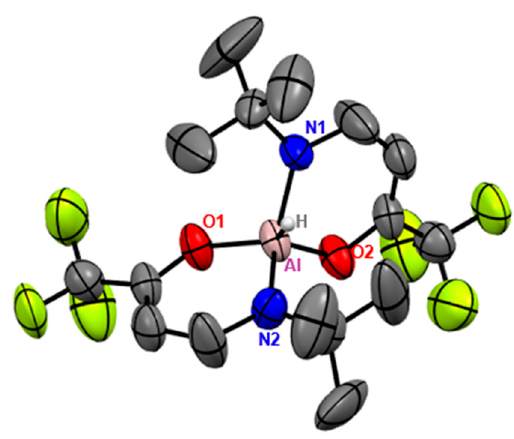
Figure 3. Molecular structure motif of compound 3 with hydrogen atoms on carbon atoms omitted for clarity.